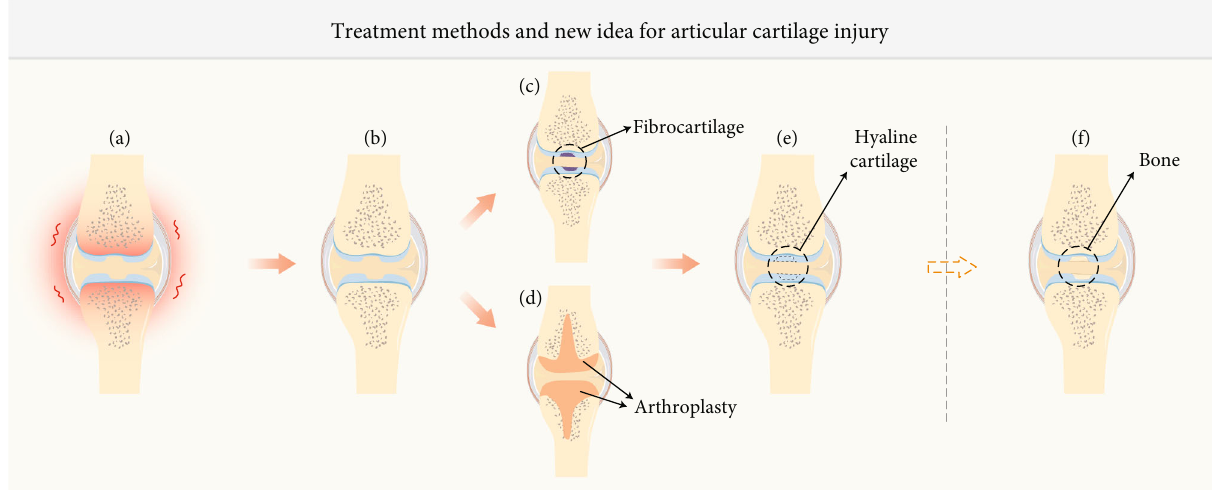
Figure 3: Treatment methods and new idea for articular cartilage injury. (a) Joint cartilage defects cause joint in fl ammation. (b) Medication can relieve symptoms. (c) Traditional repair techniques such as MF form fi brocartilage. (d) Arti fi cial joint replacement surgery reconstructs the articular surface. (e) Ideal form of cartilage regeneration. (f) New ideas for cartilage